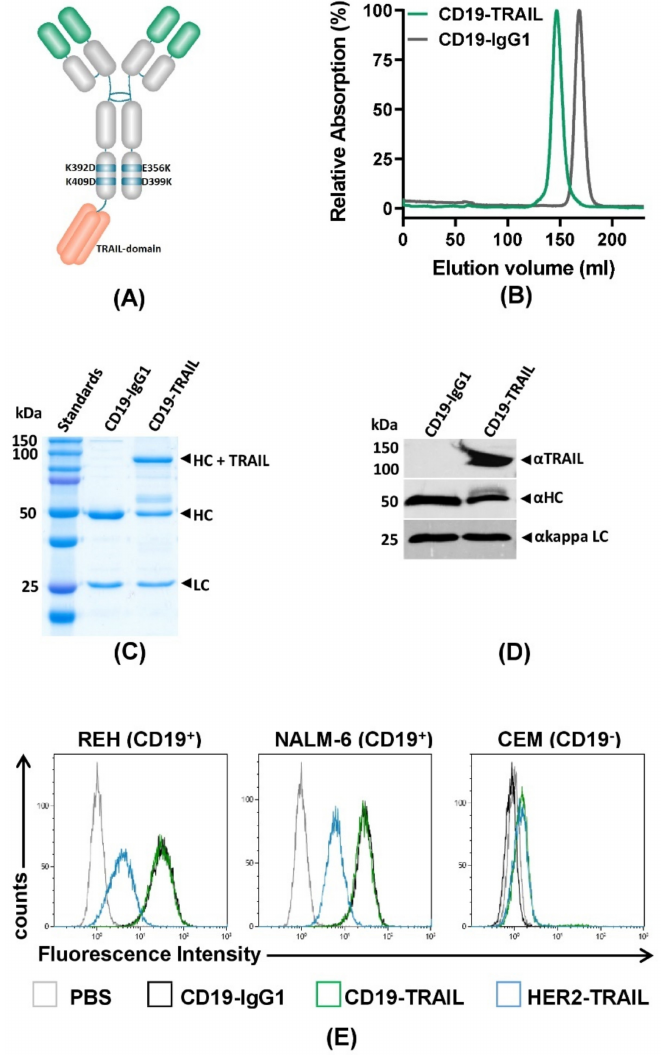
Figure 1. Generation of a target-specific CD19-TRAIL fusion construct: ( A ) Schematic illustration of a CD19-TRAIL fusion construct (CD19-TRAIL) consisting of one heavy chain with two amino acid exchanges (E356K and D399K) and a second heavy chain carrying two amino acid exchanges (K392D and K409D) and a C-terminal fusion of a single chain TRAIL domain, resulting in a heterodimeric antibody promoting TRAIL-receptor trimerization in CD19-positive (CD19 + ) target cells; ( B ) Purity of CD19-TRAIL and CD19-IgG1 was analyzed by size exclusion chromatography under native buffer conditions, and peak fractions were collected. Representative chromatography image of the isolated and re-analyzed peak fraction (normalized to maximum absorption) is shown; ( C , D ) Purity and molecular masses of CD19-TRAIL and CD19-IgG1 were further validated using SDS-PAGE under reducing conditions followed by staining with Coomassie blue and D) Western blot analyses with immunodetection of TRAIL as well as antibody heavy and light chains. HC = heavy chain, LC = light chain; ( E ) Specificity of the binding capacity of CD19-TRAIL and CD19-IgG1 compared to a HER2-TRAIL control antibody was tested on the CD19 + BCP-ALL cell lines REH and NALM-6 cells and the CD19-negative (CD19 − ) T-ALL cell line CEM by flow cytometry analyses. Antibodies were detected with a FITC-conjugated anti-human IgG Fc F(ab (cid:48) )2 secondary antibody. PBS served as control for background staining. Depicted data show representative pictures of n = 3